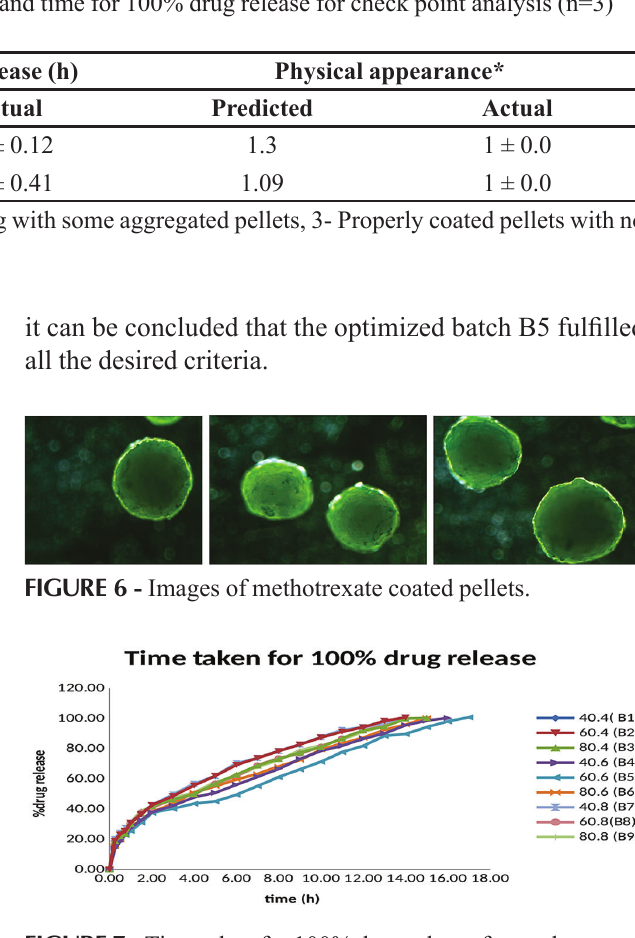
FIGURE 7 - Time taken for 100% drug release for methotrexate coated pellets.